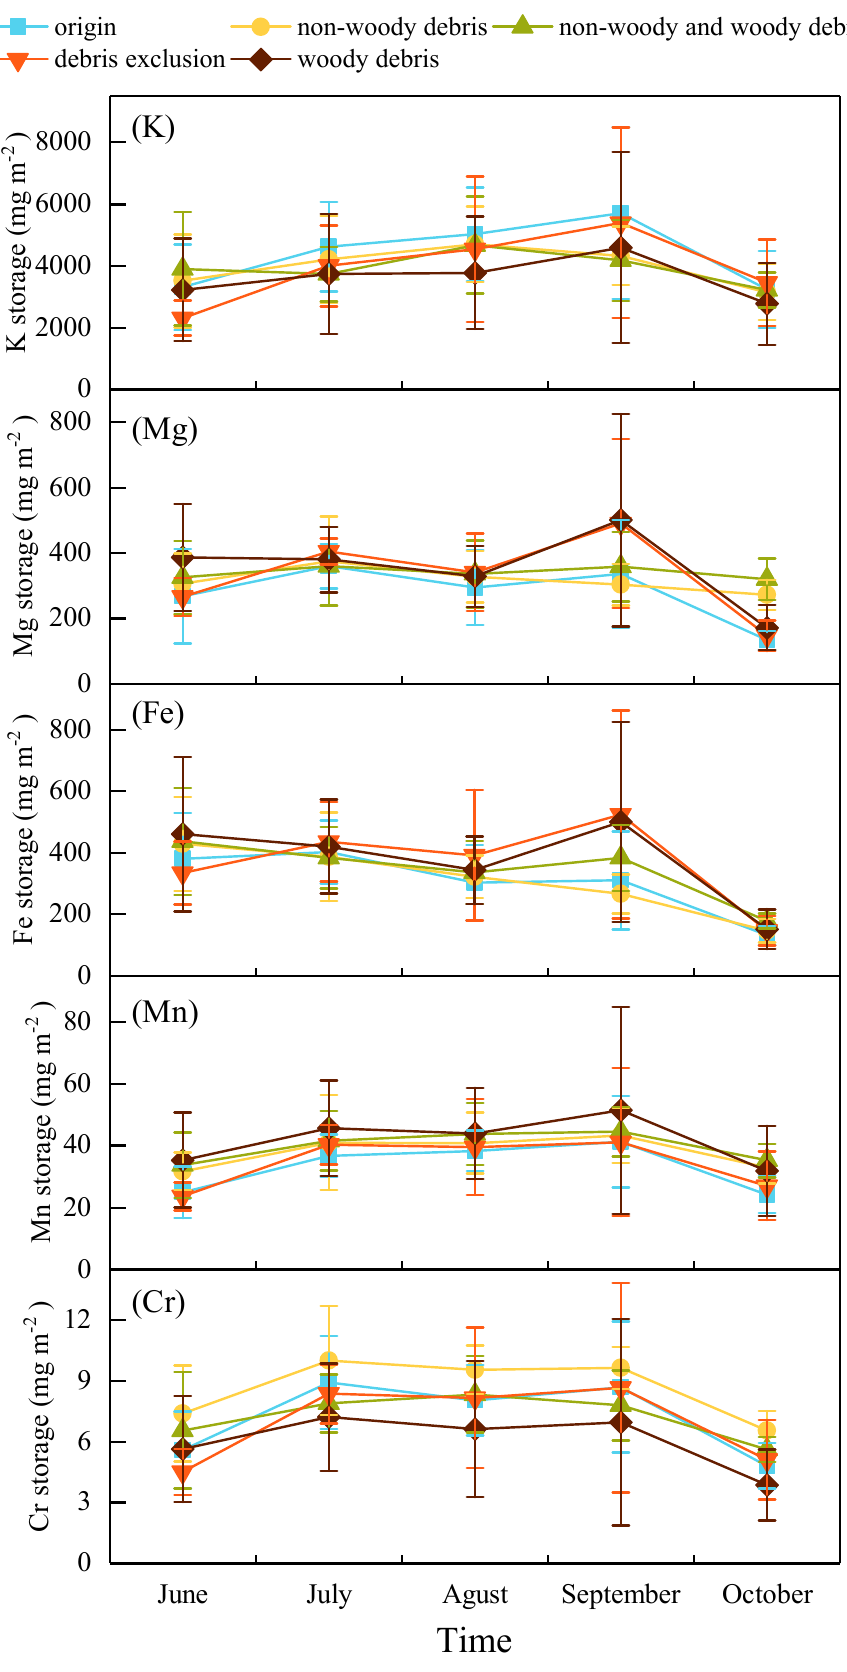
Figure 6. The K, Mg, Fe, Mn and Cr storage of the sediment in the stream with different plant litter input conditions.